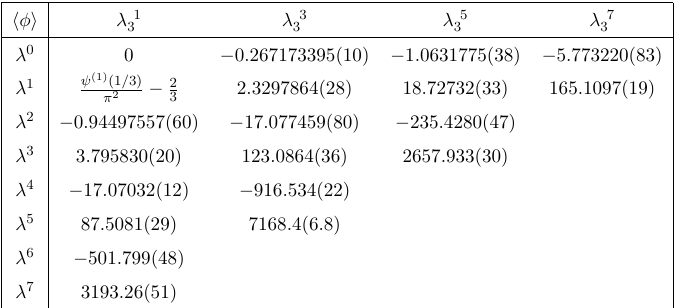
Table 7 . Perturbative coe(cid:14)cients for the VEV with independent cubic and quartic coupling (cid:21) and (cid:21) up to eight total vertices. We set